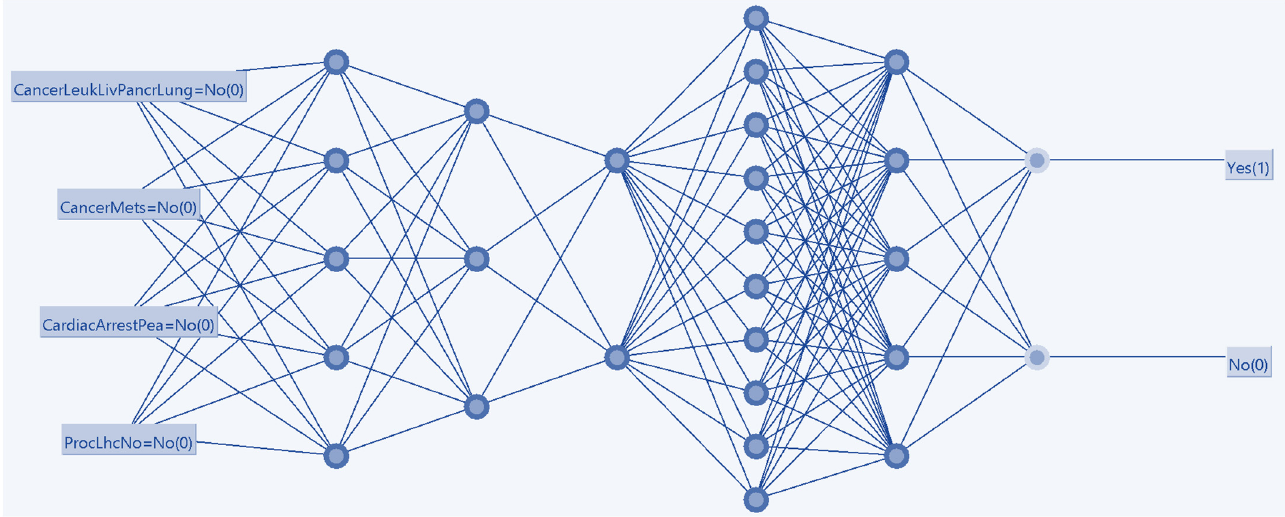
Figure 5. Deep learning model with a backward propagation artificial neural network of cardiac arrest morality in active cancer ( N = 6,656,883).